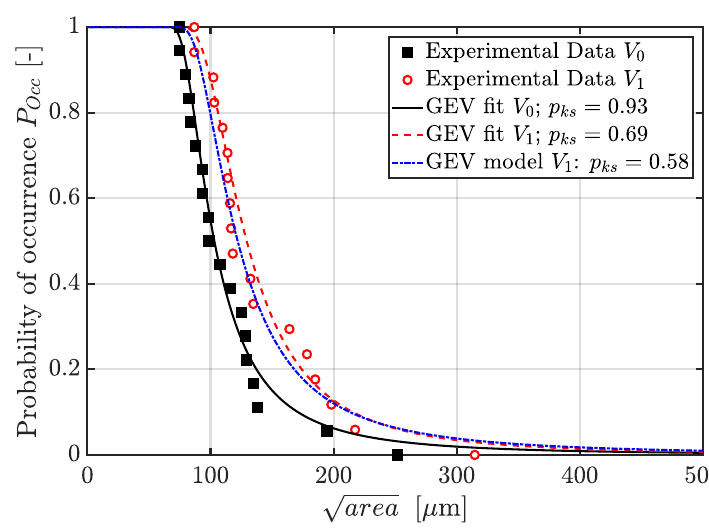
Figure 12. Probability of occurrence of critical defect sizes in specimen A and